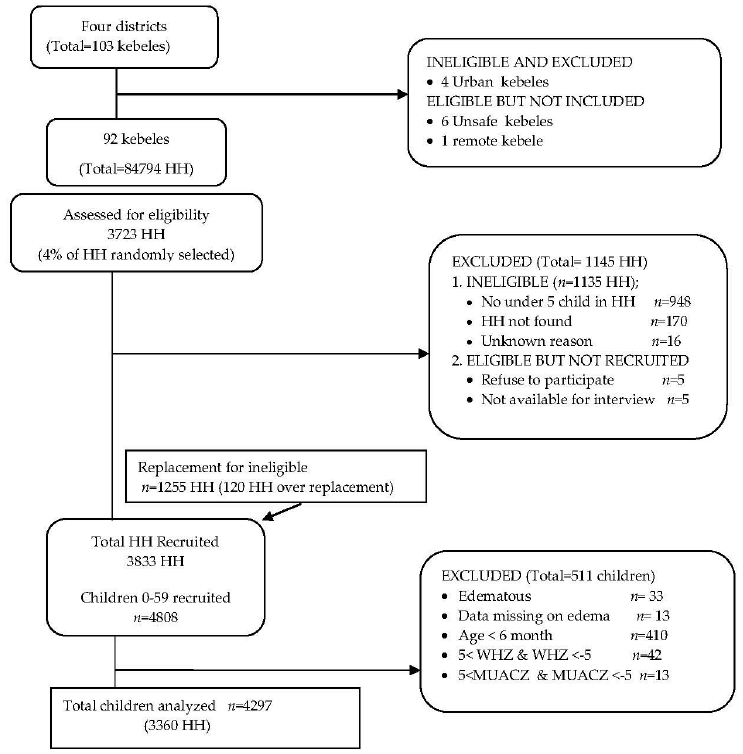
Figure 1. Participants flow chart (HH: household).